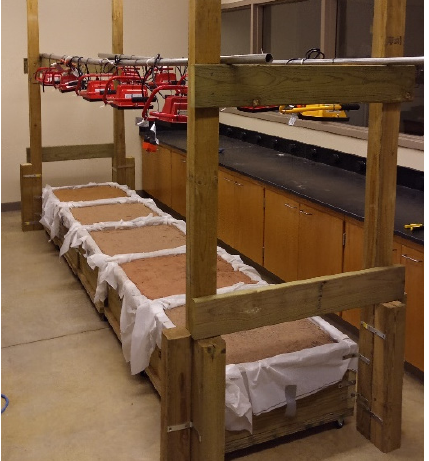
Figure 3. Shows the lab setup of the 5 KRC soils. The soils in order from top left to bottom right: Fine, Coarse, Rink, Stability, and 2NS. Above each bin are two 500 W work